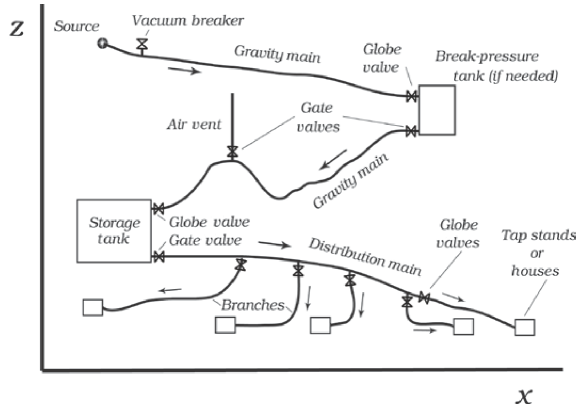
Figure 1. Element schematic of a